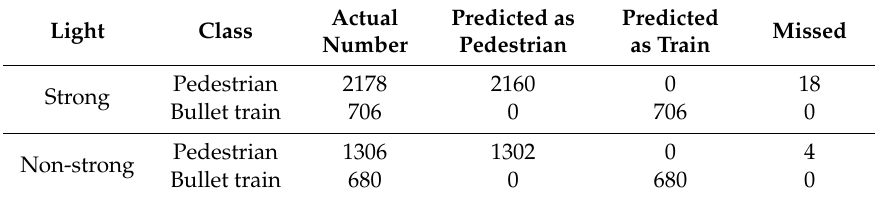
Figure 11. Images with different light intensities. (a) strong-light images. (b) non -strong light images. Table 12. Experimental results on the strong light and non-strong light.